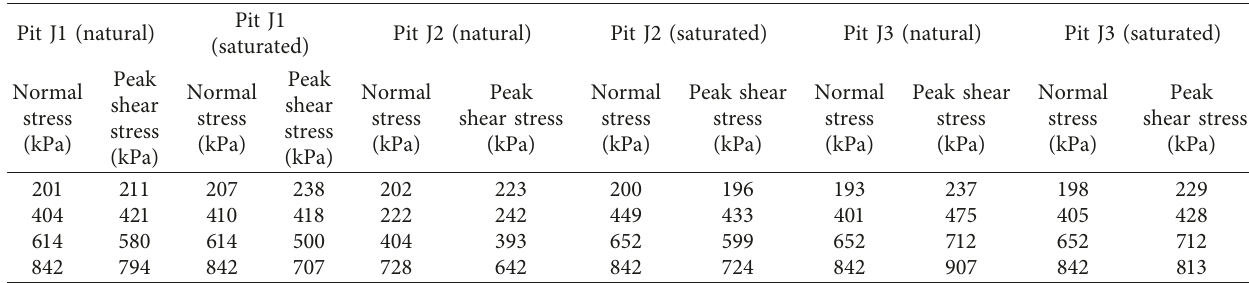
Table 4: Loading test